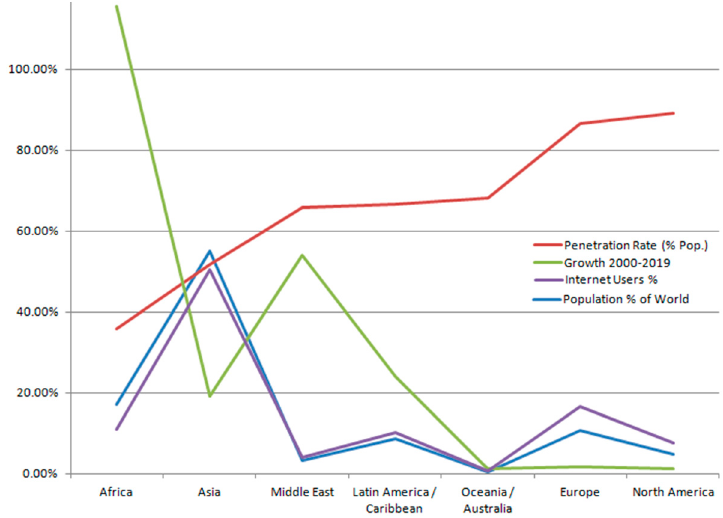
Figure 5. Comparison of current Internet usage between Africa and other continents by the year 2019.